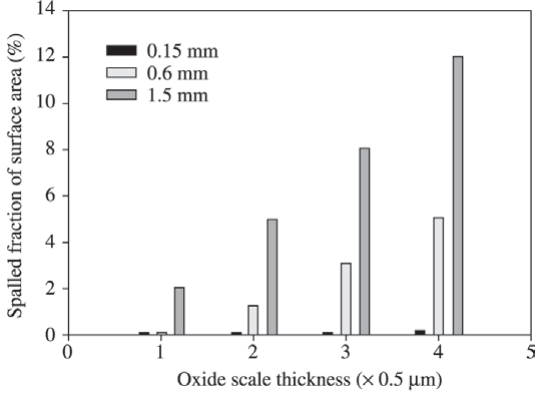
Figure 2. Oxide spallation average data at cooling after isother- mal oxidation in oxygen as a function of substrate thickness for the bi-stabilised Fe-18Cr-TiNb